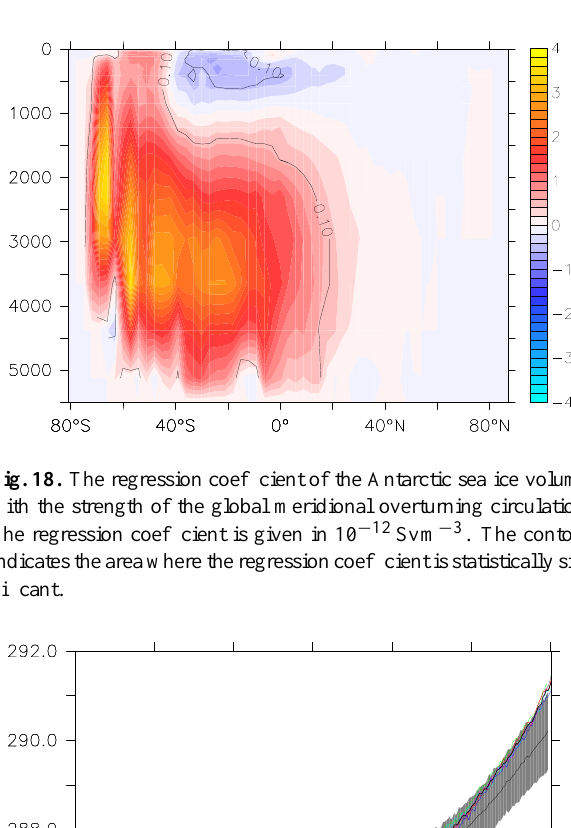
Fig. 20. The time series of the annual mean two meter temperature in SPEEDO (top), the difference in the 100 year mean two meter temperature of the 2 × CO 2 experiment and the control run in the second 100 years in SPEEDO (centre), and the mean change in the two meter air temperature to a doubling of the CO 2 concentration in the CMIP3 multi-model ensemble (bottom). The contours in the lower panel indicate the standard deviation of the CMIP3 ensemble. All quantities are in K .